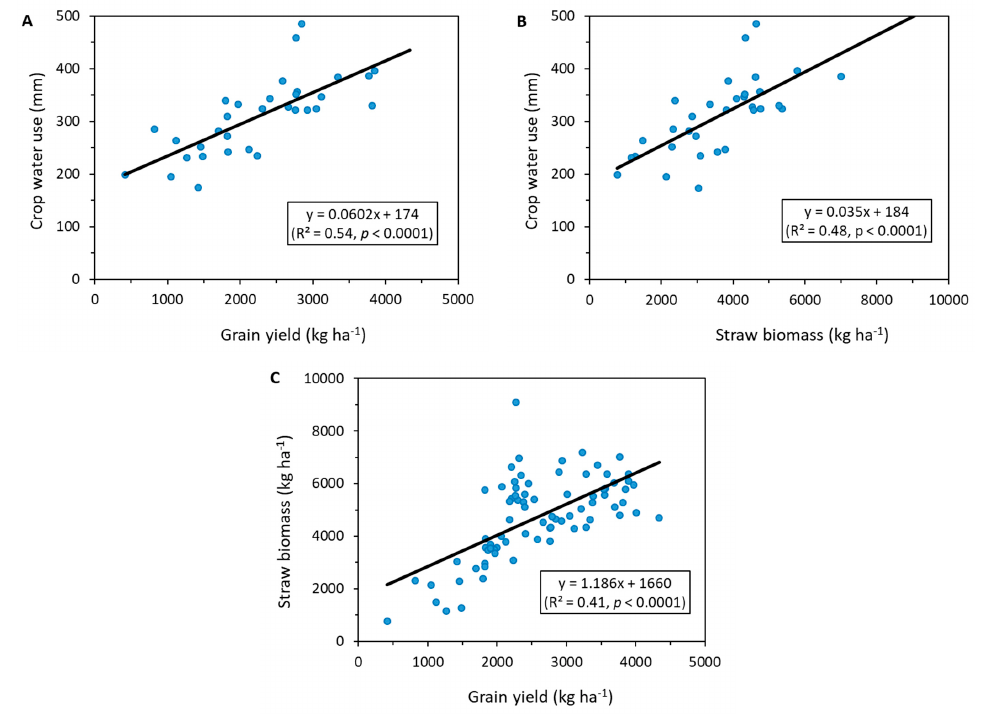
Figure 2. Relationships between growing season crop water use and grain yield ( A , n = 32), between growing season crop water use and straw biomass ( B , n = 32), and between crop straw biomass and grain yield ( C , n = 78), all for spring wheat. The data were obtained from published work in the Canadian Prairies: [8,11] for ( A , B ), and [8,11,42–44] for ( C ). Each data point represents a site-year field experiment.